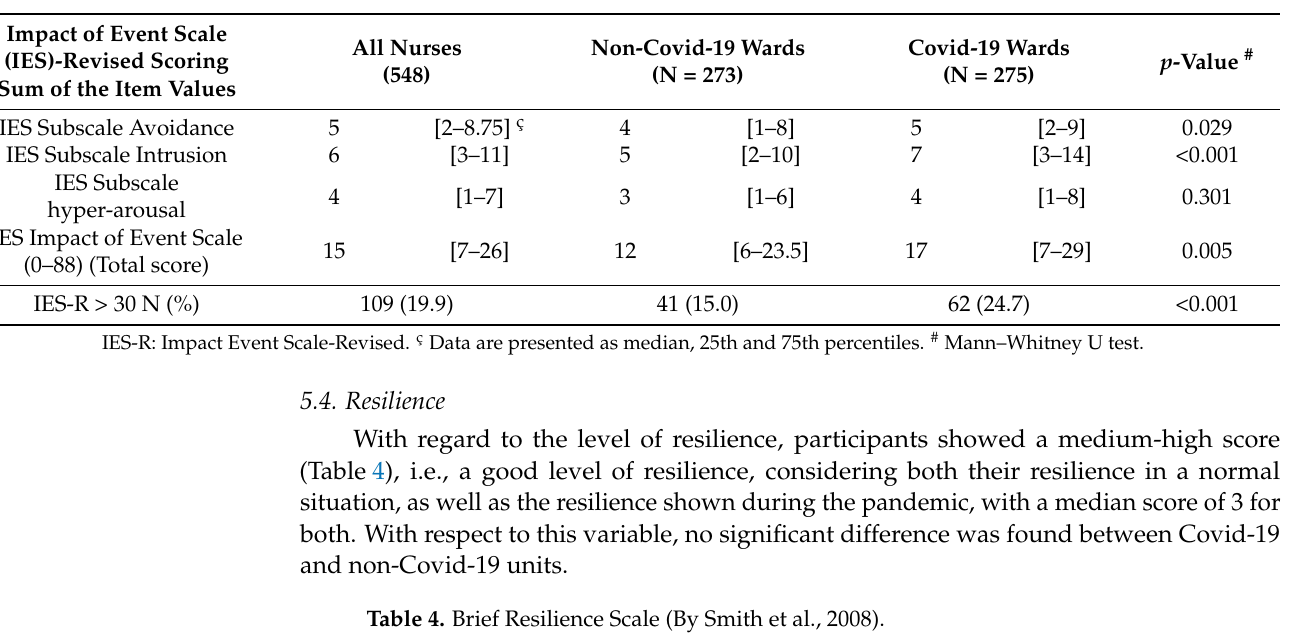
Table 3. Comparison of the IES-R score and its subscales between Covid-19 and non-Covid-19 wards.